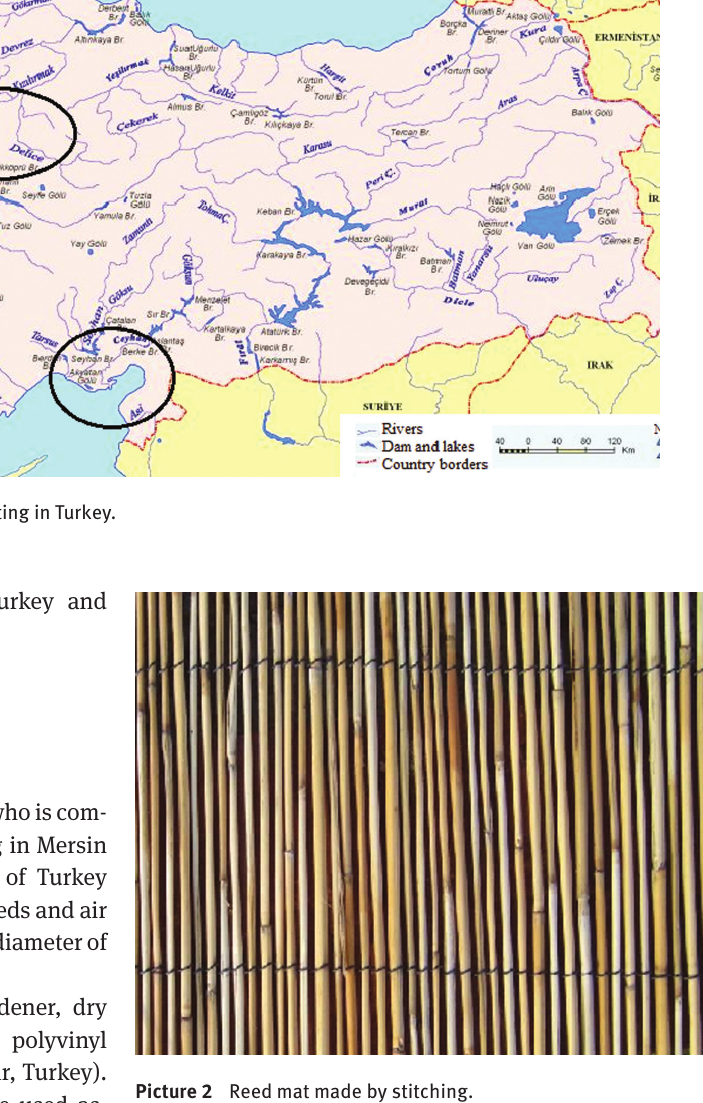
Picture 2 Reed mat made by